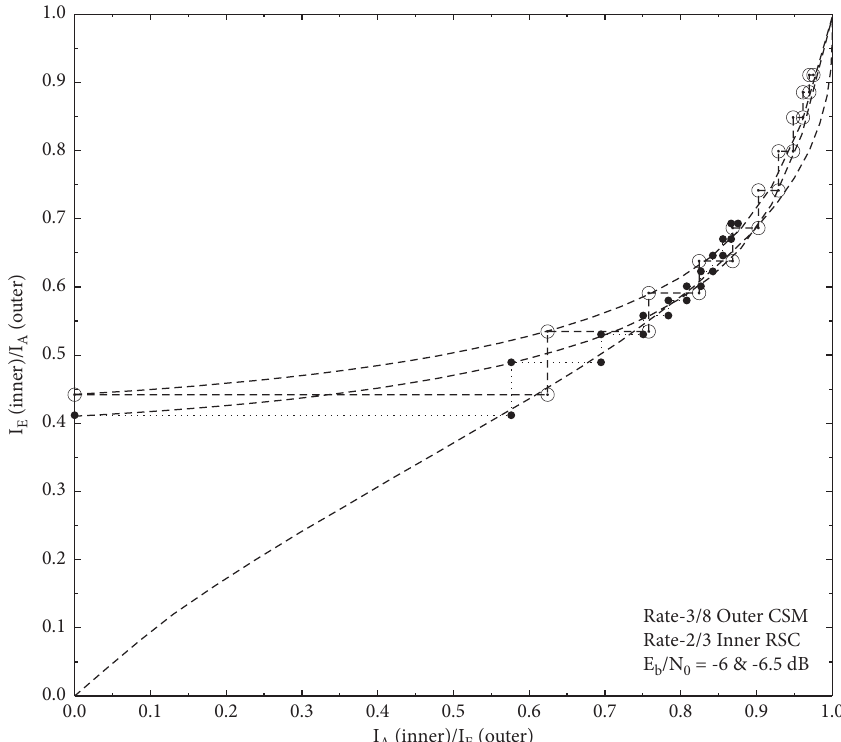
Figure 7: EXIT chart curves and decoding trajectories for Rate-3/8 CSM ( Mapping-II ) scheme.